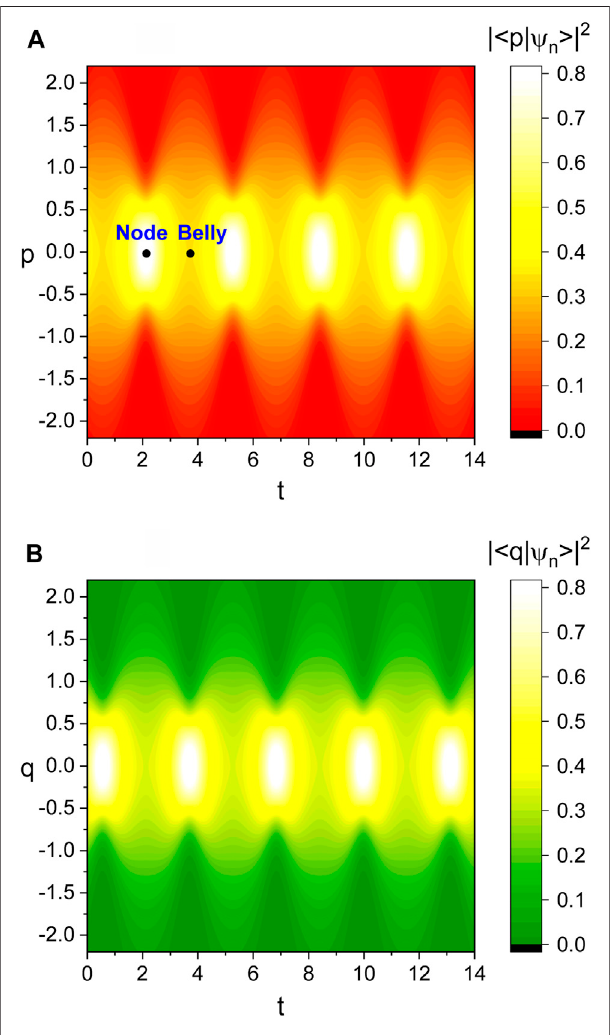
FIGURE 3 | (A) is the density plot of the probability density | 〈 p | ϕ n 〉 | 2 given as a function of p and t . (B) is the density plot of | 〈 q | ϕ n 〉 | 2 given as a function of q and t (comparison purpose). The values that we have taken are K R (cid:1) 1, K I (cid:1) 1, A (cid:1) 1, B (cid:1) 5, C (cid:1) 2, ξ (cid:1) 0, ω (cid:1) 1, Z (cid:1) 1, ϵ (cid:1) 1, t 0 (cid:1) 0, and φ (cid:1) 0.